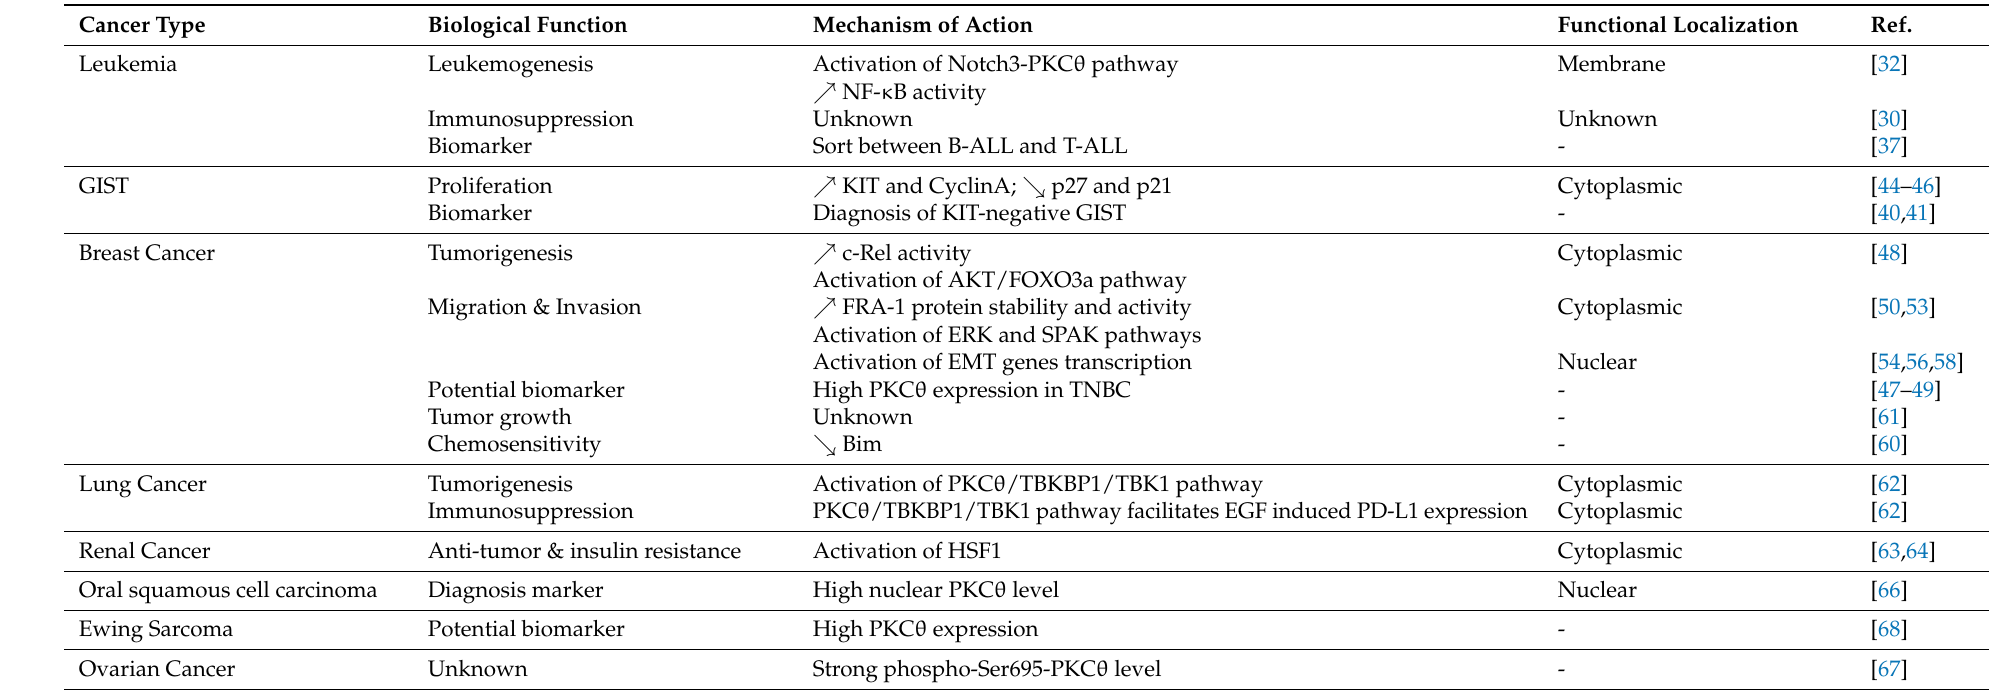
Table 1. Summary of PKC θ function and mode of action in various cancer